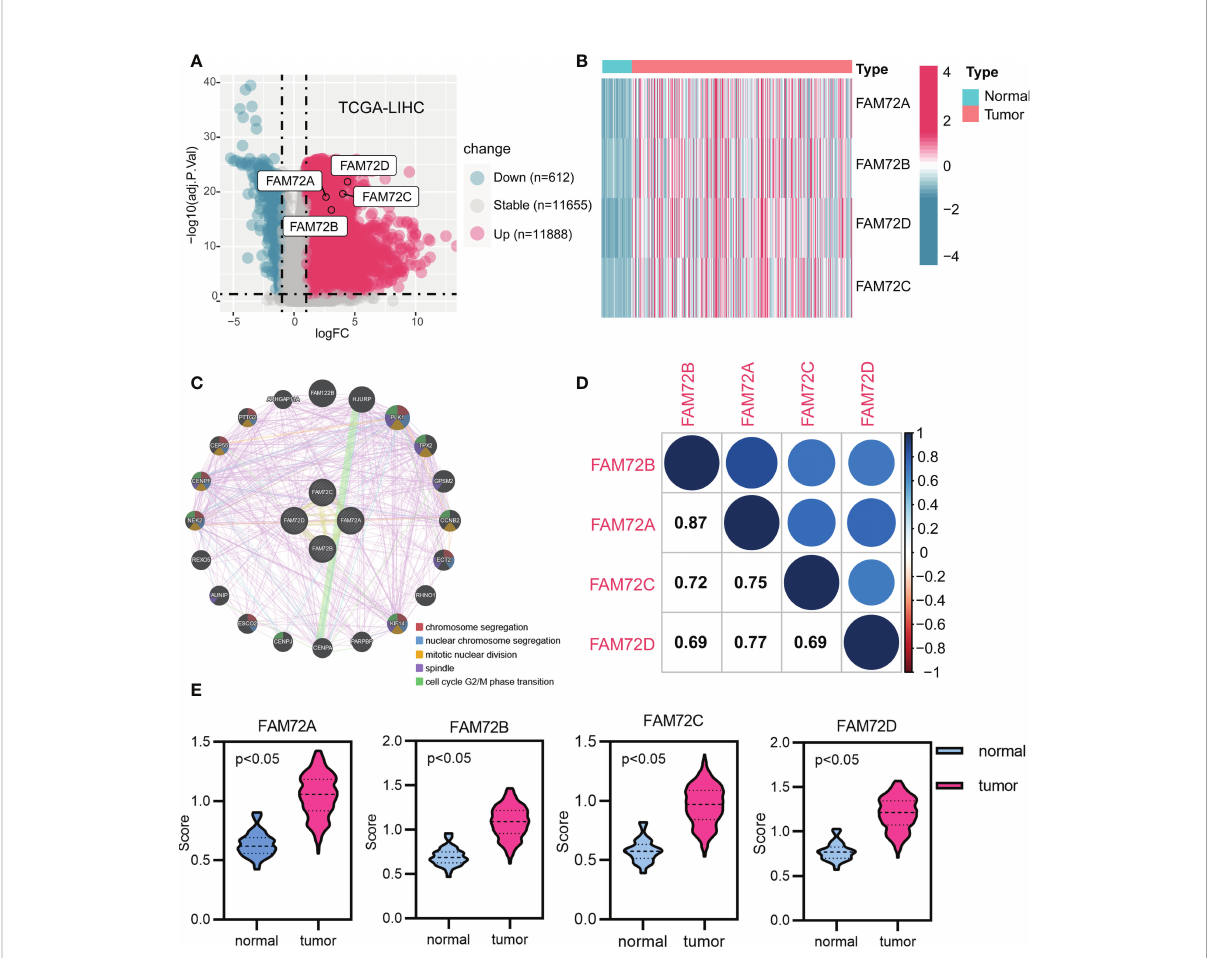
FIGURE 1 Gene expression and interaction network of FAM72 family members in TCGA-LIHC cohort. (A) Volcano plot of expression pro fi les. (B) Heatmap of expression pro fi les. (C) The gene network analyzed using the GeneMANIA database. (D) Correlation analysis among FAM72 family members. Statistical analyses were performed using the Spearman correlation test. (E) Comparison of activity scores between the normal and tumor groups. Statistical analyses were performed using the Wilcoxon